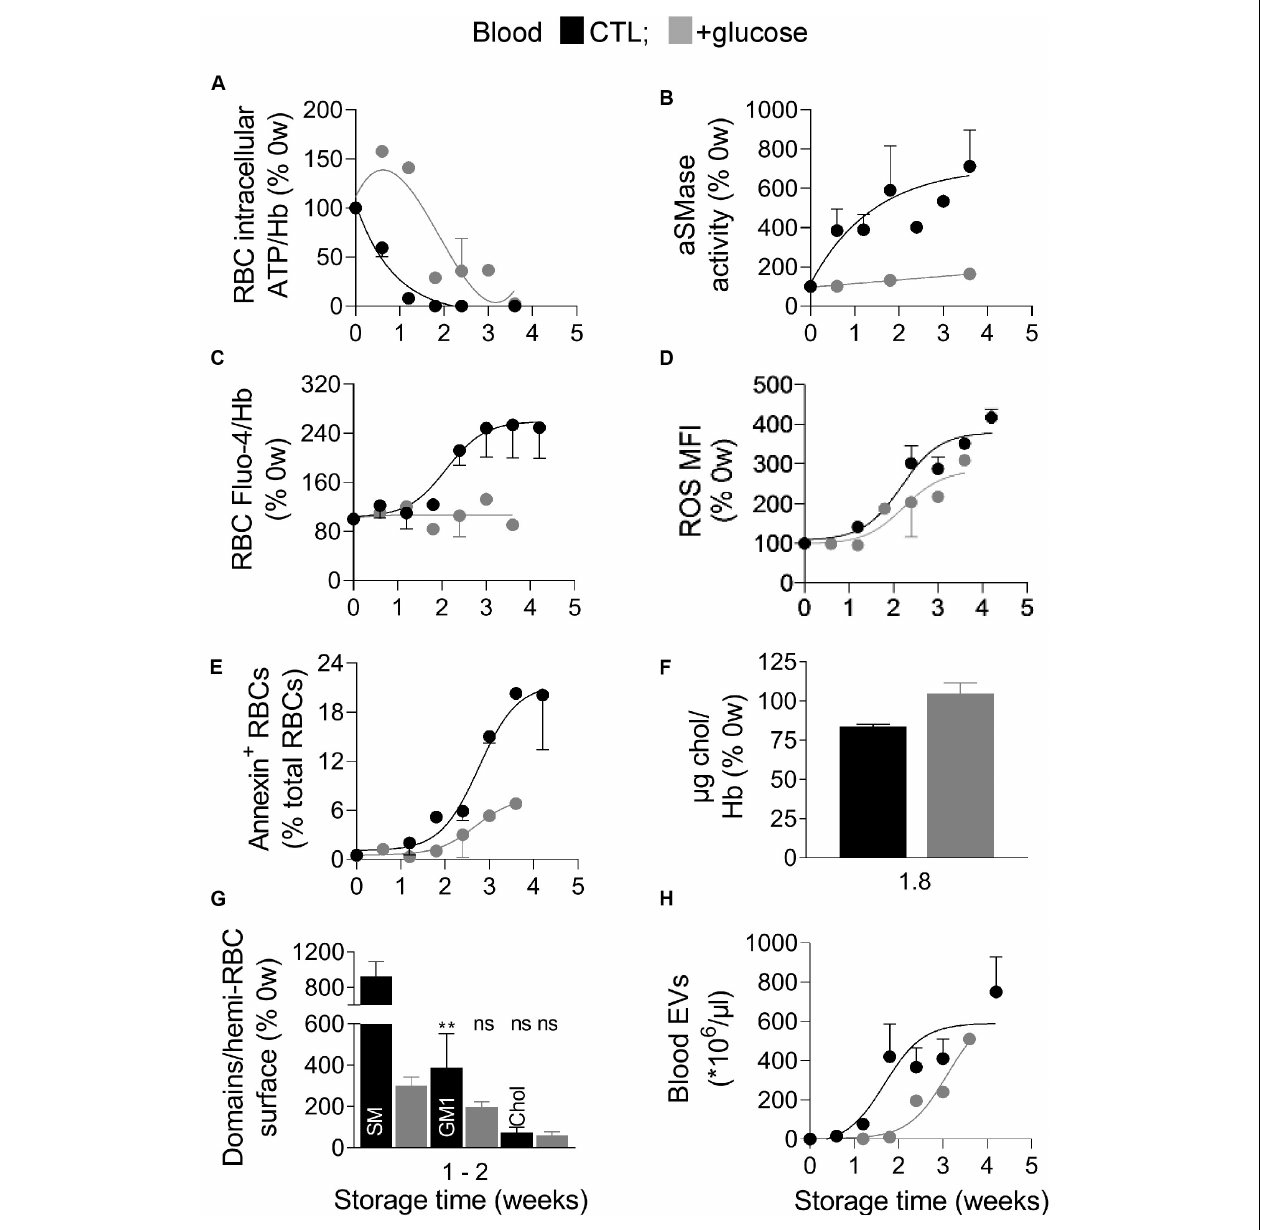
FIGURE 7 | Blood glucose supplementation delays ATP drop, ROS accumulation and EV release, decreases the extent of PS exposure and of SM- and GM1-enriched domain increase and abrogates the increase of aSMase activity and calcium content. Blood samples were stored for the indicated times at 4 ◦ C in K + /EDTA tubes supplemented or not (black symbols) with a glucose-enriched solution (gray symbols) and measured for the intracellular ATP (A) , aSMase activity (B) , intracellular calcium and ROS contents (C,D) , PS surface exposure (E) , membrane cholesterol (chol) content (F) , lipid domain abundance (G) , and blood EVs (H) . (A) RBC ATP content determined as in Figure 1E . (B) aSMase activity evaluated as in Figure 4H . (C) RBC calcium content measured as in Figure 3A . (D) RBC ROS content assessed as in Figure 3C . (E) Proportion of PS-exposing RBCs determined as in Figure 4G . (F) RBC membrane cholesterol (chol) content, measured as in Figure 4A . (G) Sphingomyelin (SM), GM1- and cholesterol-enriched domain abundance, counted as in Figure 5 . (H) Blood EV abundance, evaluated as in Figure 2C . Data are means ± SD of 1 (A,C–E,H) or 2 independent experiments [ B,F,G (SM domains)] or means ± SEM of 3–4 independent experiments [ G (GM1 and chol domains)]. Kruskal–Wallis test followed by Dunn’s multiple comparisons test to compare GM1- and chol -enriched domains at 0 weeks, 1–2 weeks – glucose and 1–2 weeks + glucose. ns, not significant; ** p < 0.01.